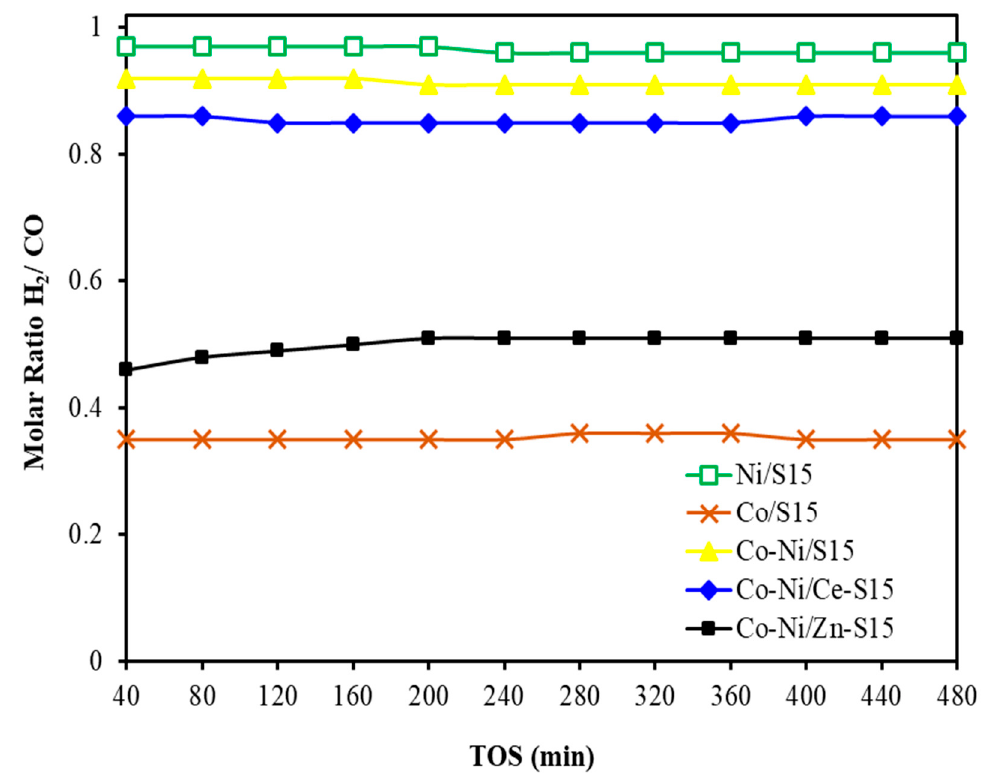
Figure 6. The molar H 2 /CO ratio of the product stream.